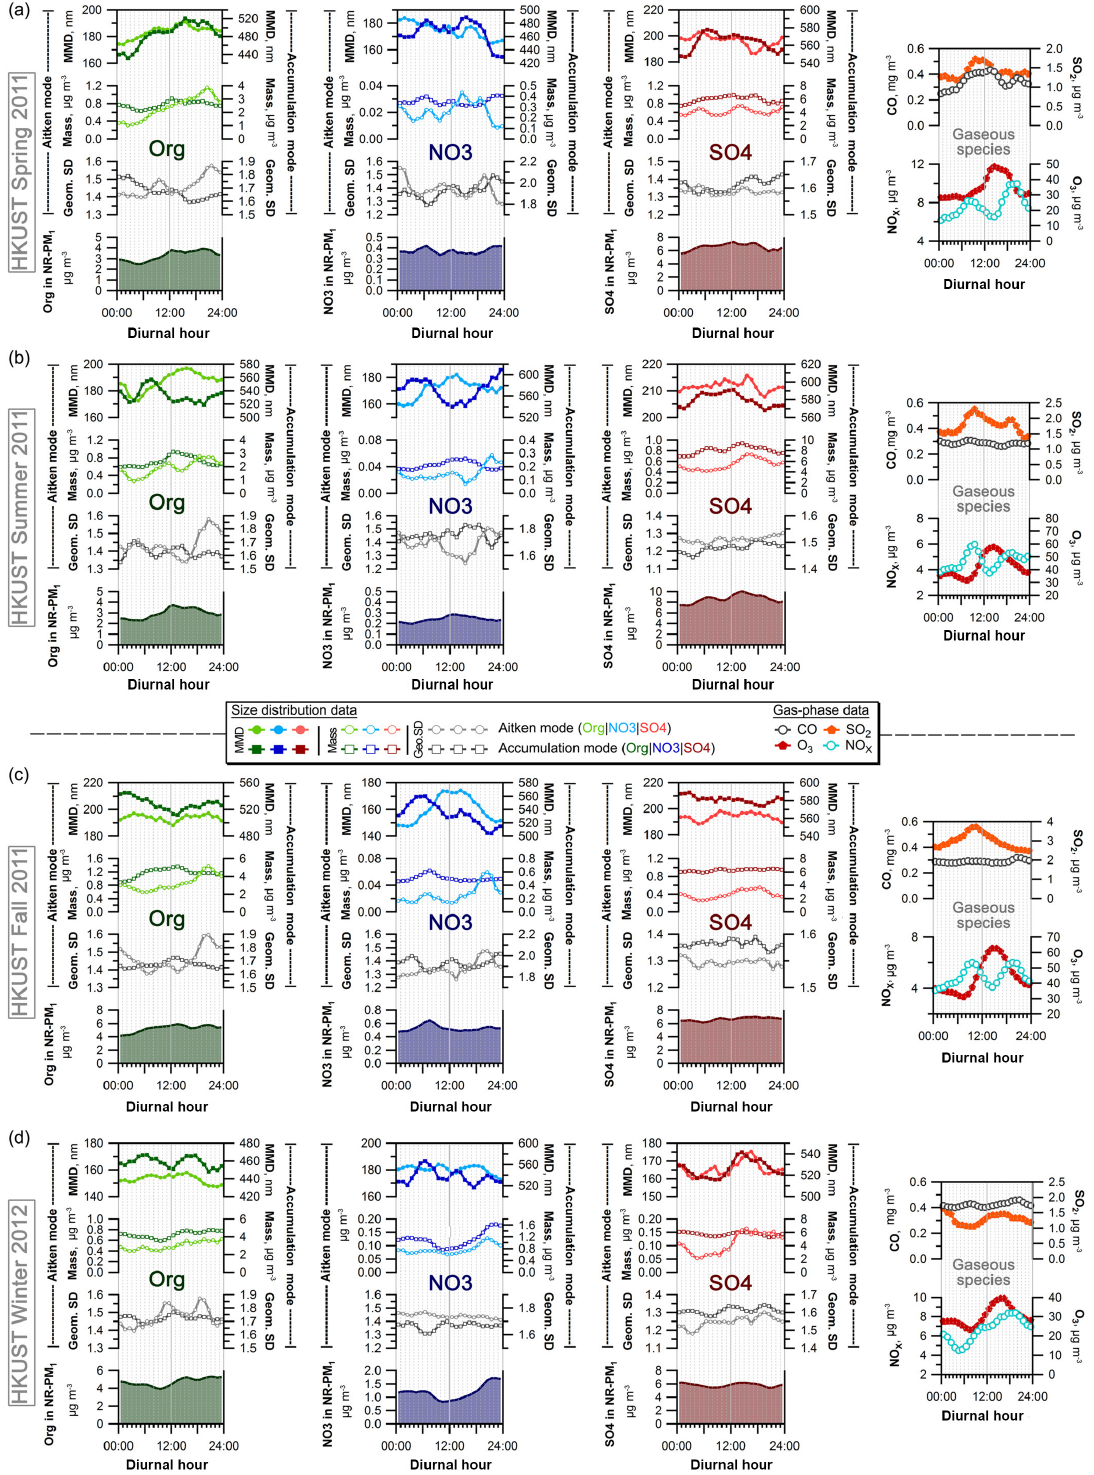
Figure 4. Diurnal variations in mode diameter (MMD), integrated-mode mass concentration, and width of the Aitken mode (lighter color) and accumulation mode (darker color) from bimodal peak fits of the bin-median reconstructed size distributions at the suburban HKUST site, as well as V-mode AMS species concentrations (line with shaded background) for organics, nitrate, and sulfate (left to right) in (a) spring 2011, (b) summer 2011, (c) fall 2011, and (d) winter 2012. The right-most panels depict the median diurnal variations in relevant gas-phase pollutants (O 3 , CO, NO x , SO 2 ) measured at the same